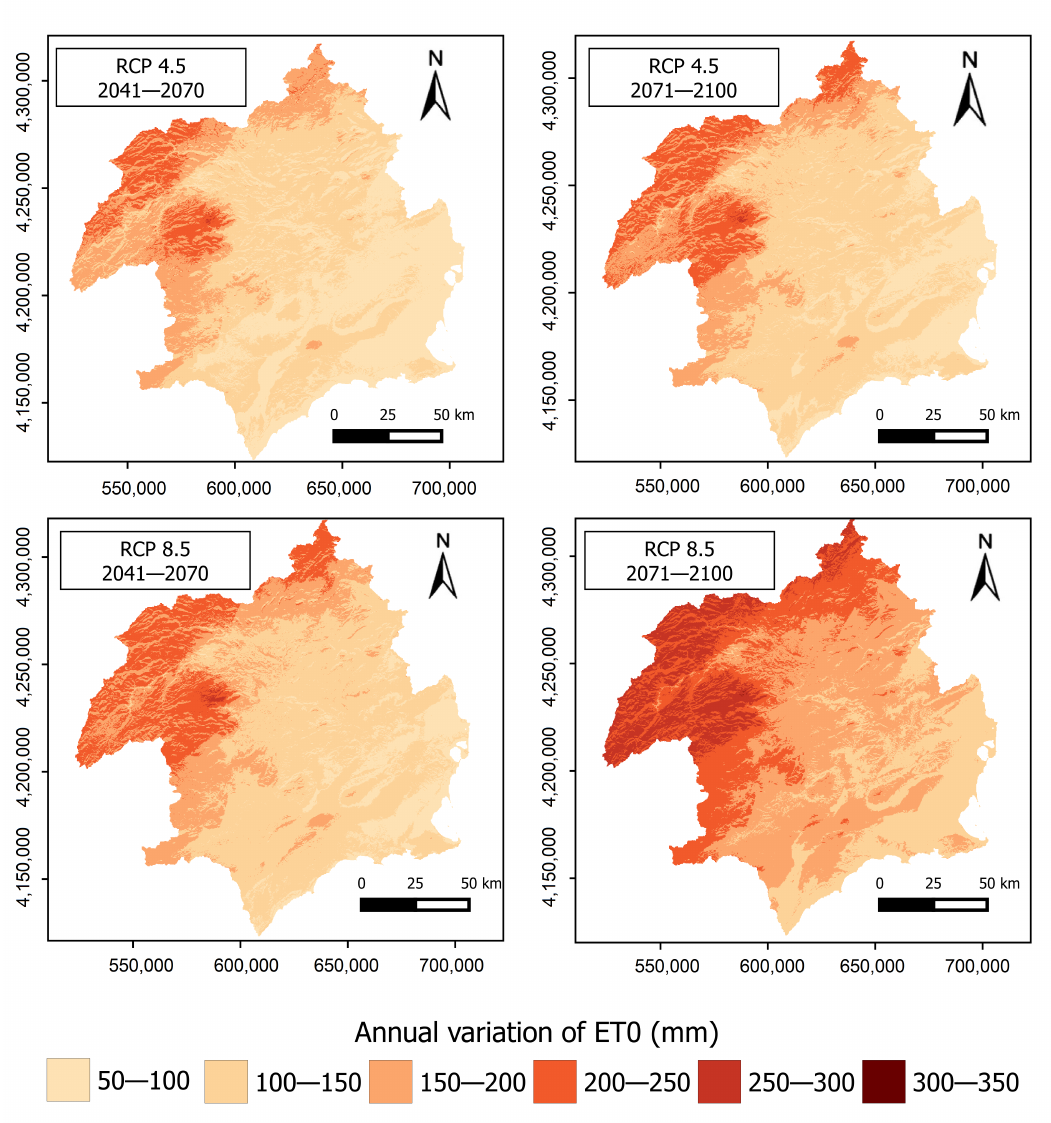
Figure 8. Spatial distribution of the annual variation of the forecasted ET 0 for the DHS for the two scenarios analyzed in the periods 2041–2070 and 2071–2100 with respect to the reference period